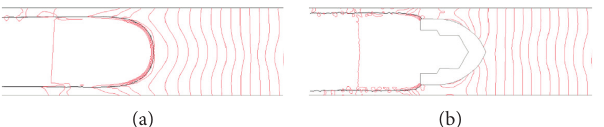
Figure 7: Comparison of the pressure contours near the penetration front at the middle location of straight segments between WAIM and W-PAIM: (a) WAIM and (b)